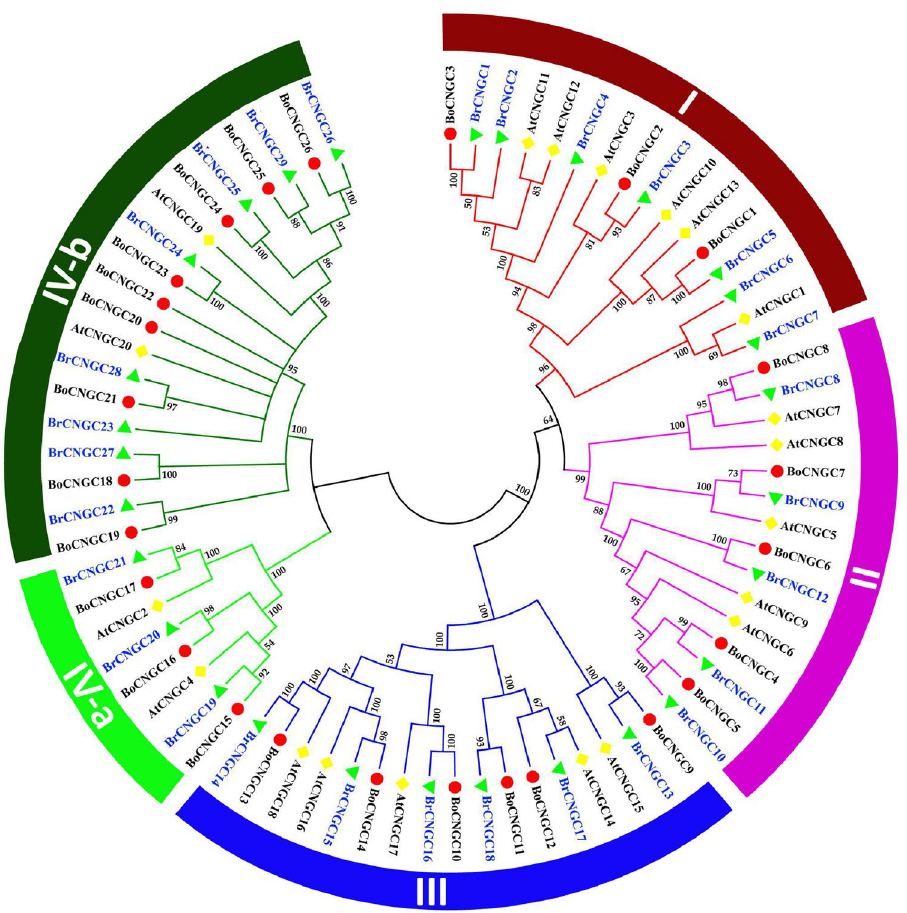
Figure 2. Phylogeny of CNGC proteins from Brassica rapa L. and A. thaliana . A maximum likelihood phylogenetic tree was created with MEGA 6.0, using the Jones–Taylor–Thornton model. The bootstrap values from 1000 replications are provided at each node. The BoCNGC proteins identified in this study are indicated with maroon diamonds, while the AtCNGCs are indicated with blue squares. Each group is highlighted in different color.